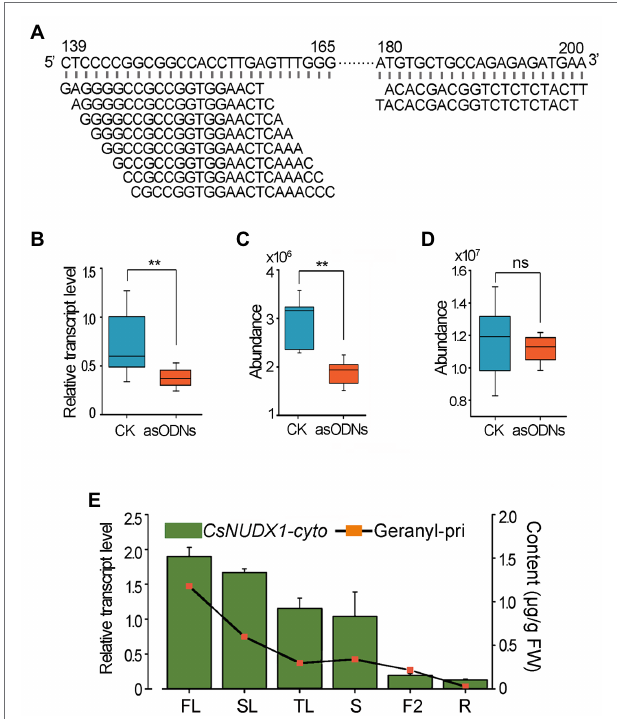
FIGURE 5 | Functional characterization of CsNUDX1-cyto in tea plants using AsODNs approach. (A) Top 10 asODNs retrieved using Soligo software (Ding and Lawrence, 2003) for CsNUDX1-cyto suppression experiments. (B) A significant reduction (** p < 0.01) in the transcript level of CsNUDX1-cyto after asODNs treatment. (C) A significant reduction (** p < 0.01) in the abundance of geranyl β -primeveroside in the treated tea tender shoots ( p < 0.01). (D) No significant change (ns) in the abundance of linalyl β -primeveroside in treated tea shoots compared to control ( p > 0.05). (E) Highly correlated tempo-spatial transcript levels of CsNUDX1-cyto and the abundances of geranyl β - primeveroside in tea plants (correlation coefficient of 0.864). FL, SL, and TL, first, second, and third leaves; S, tender shoot stem; F2, flowers at stage 2, slightly opened; R, tender roots. CsNUDX1-cyto , Transcript levels of CsNUDX1-cyto in different organs of “SCZ” plants; Geranyl-pri, Abundances of geranyl primeveroside in different organs of “SCZ”